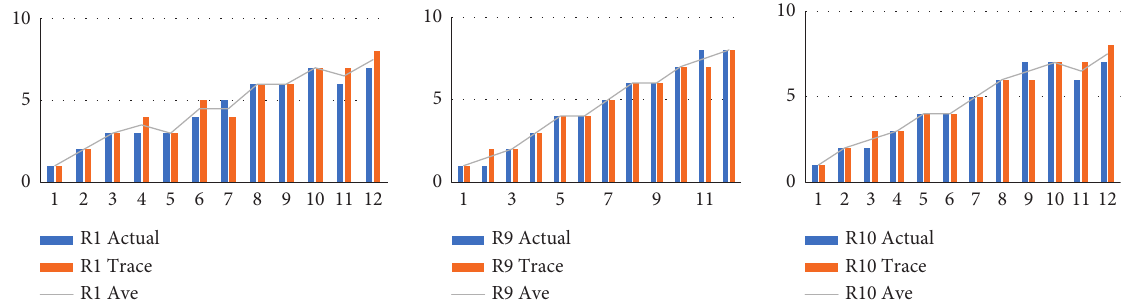
Figure 4: Chart of actual, trace, and average progressions of the pupils identified as regular